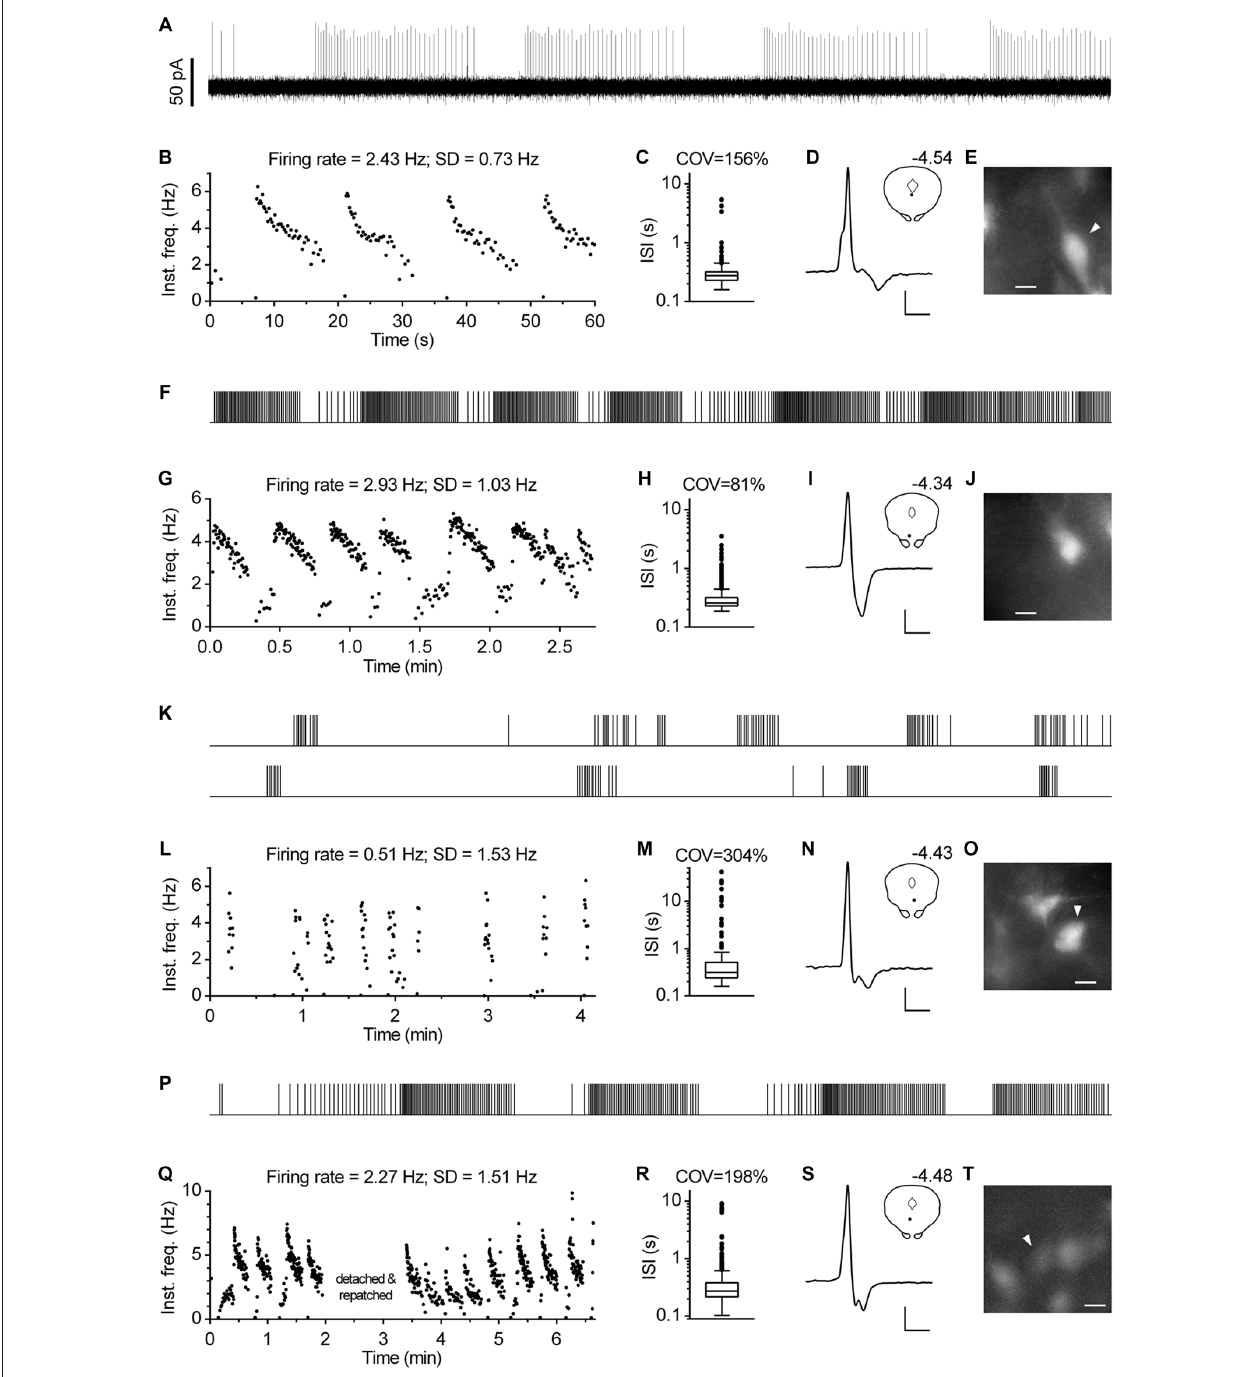
FIGURE 9 | Subset of serotonergic neurons exhibits low frequency oscillation in the firing rate. (A) 1-min-long segment of representative recording of serotonergic neuron exhibiting oscillations in firing rate. PCG mouse, PE-induced firing. (B) Time-course of instantaneous frequency of the recording shown in (A) . SD stands for standard deviation of instantaneous frequency. (C) Box plot shows distribution of ISI of the same recording. Log scale. Boxes represent medians and the IQR. Whiskers denote 1.5 IQR. COV denotes coefficient of variation of ISI. (D) Average spike of the same recording. Scale bars: 15 pA, 1 ms. Inset shows the anatomical location of the neuron. The number indicates distance from bregma. (E) Fluorescence image of the recorded neuron. Scale bar: 10 µ m. (F–J) Representative recording of low-frequency oscillation in a serotonergic neuron of PRY mouse. NA-induced firing. (F) Spike train. Duration, 164 s. (G) Time-course of instantaneous frequency. (H) Distribution of ISI. Log scale. (I) Average spike. Scale bars: 20 pA and 1 ms. Inset shows the anatomical location of the neuron. The number indicates distance from bregma. (J) Fluorescence image of the recorded neuron. Scale bar: 10 µ m. (K–O) Representative recording